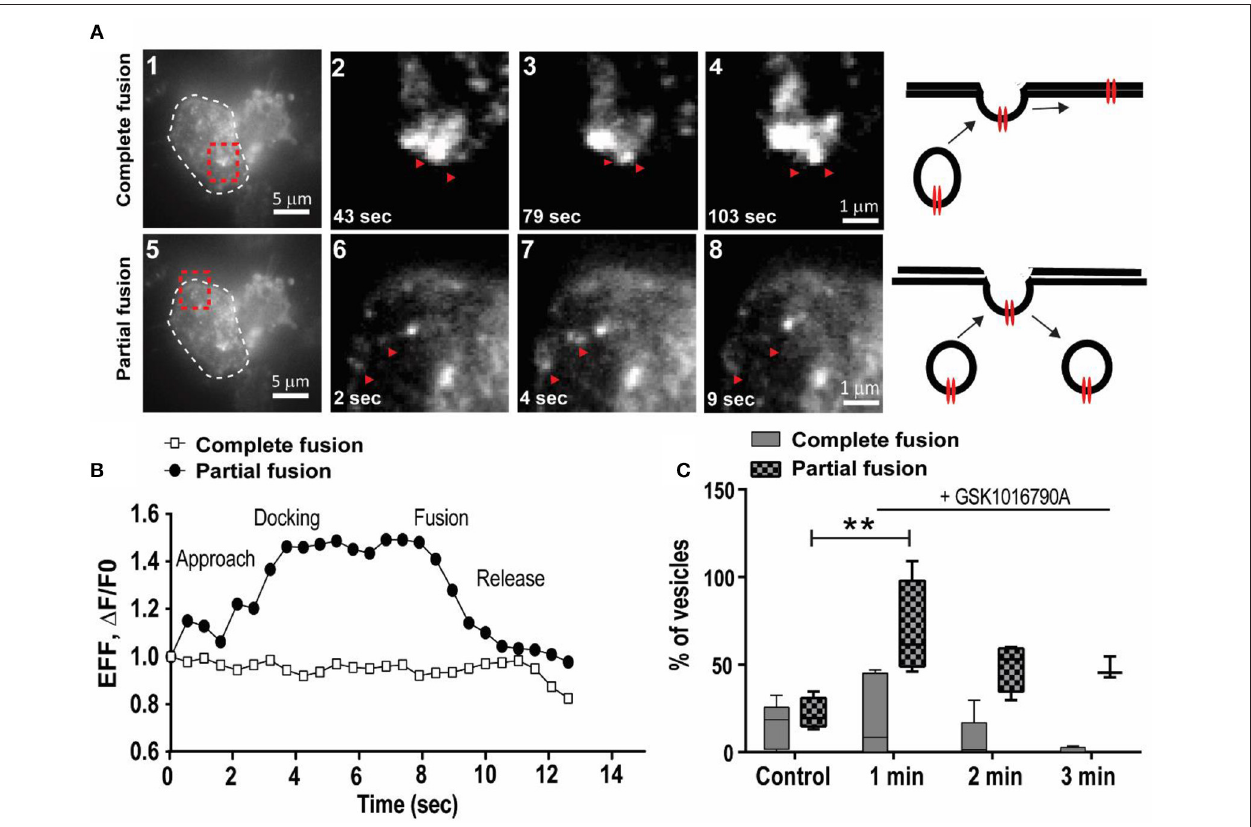
FIGURE 4 | GSK1016790A induced the partial fusion of TRPV4 channels to the plasma membrane. (A) TIRF images show two modes of trafficking for TRPV4-Venus molecules, complete, and partial fusion (red arrows), cell border is labeled with white dashed line in a1 and a5 and selected regions (shown by red dashed line is magnified in a2–4 and a6–8. Images are selected from Supplementary Video 2 . (B) Representative graphs from data depicted in (A) showing the dynamics of complete and partial fusion of TRPV4-Venus expressed in HEK293 cells. (C) During the first minute of applying GSK1016790A there was an increase in the density of TRPV4 channels with partial fusion. Data are representative of at least four independent experiments. ** P < 0.01, One-Way ANOVA, Dunnett’s post-hoc test.